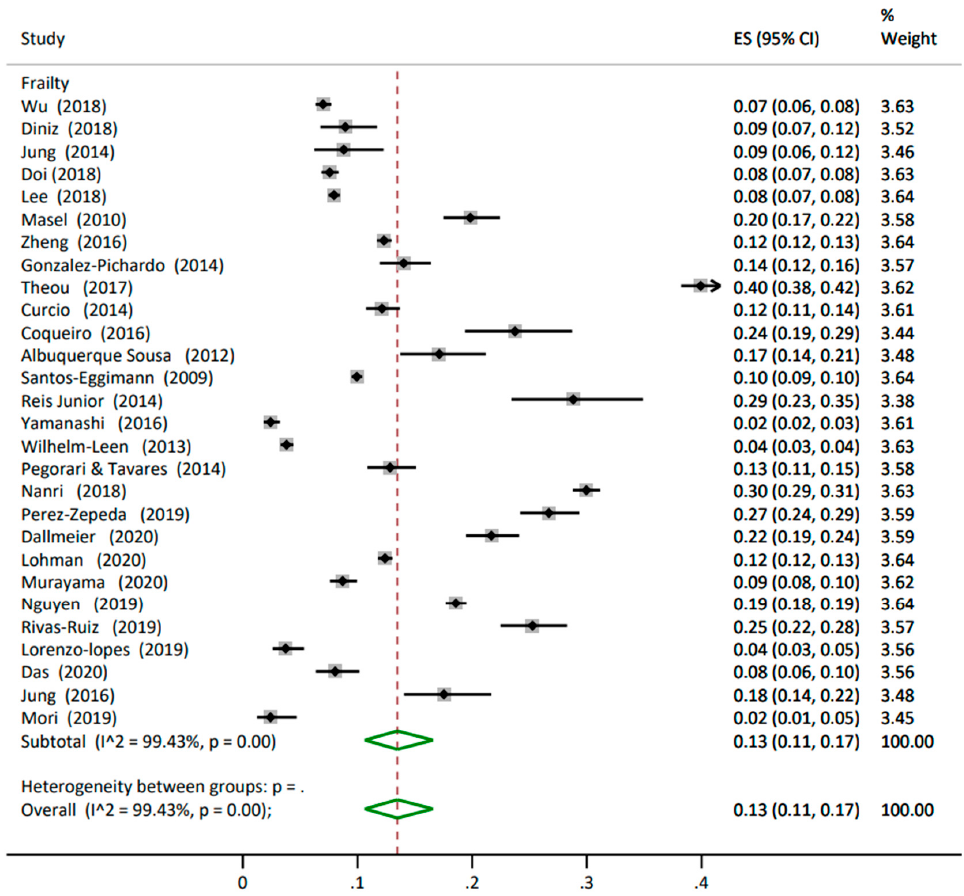
Figure 3. Forest plot for the prevalence of frailty in older people living in the community. ES: effect size; CI: confidence interval.